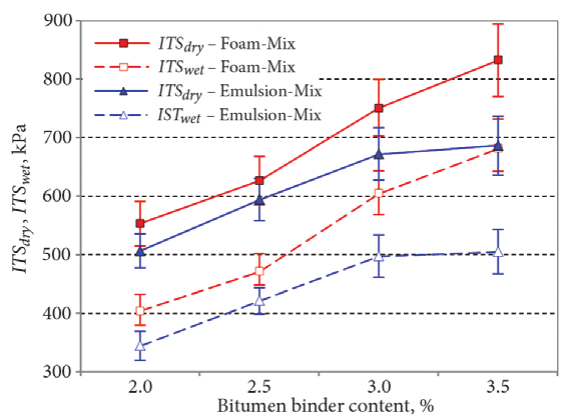
Fig. 4. The impact of the binding agents (FB, BE) content on indirect tensile strengths before and after